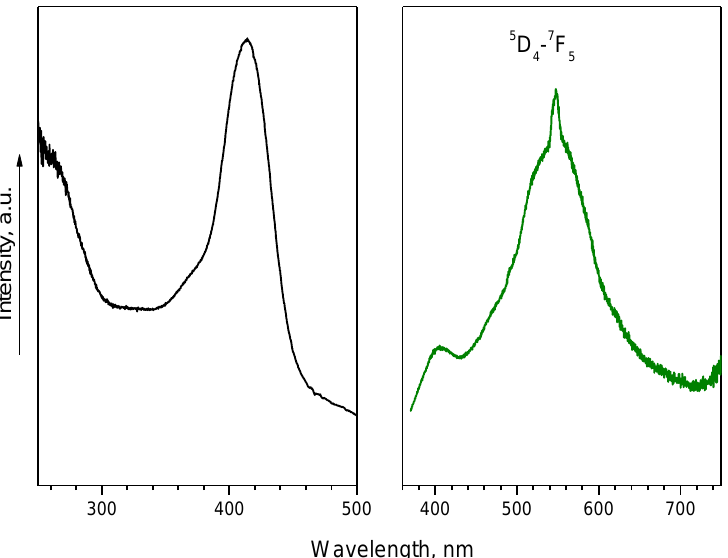
Figure 3. Luminescence excitation ( left ) and luminescence ( right ) spectra of complex 3 in solid state at 300 K, l reg = 545 nm, and l exc = 270 nm.